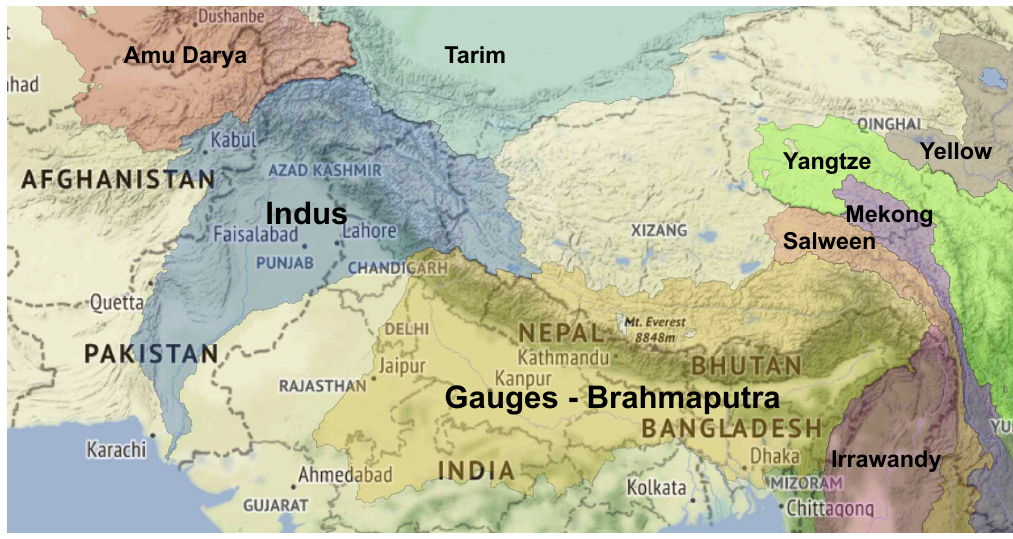
Figure 1. The ten main river basins located in the Hindu-Kush-Karakoram-Himalaya ( HKKH ) region (from west to east): Amu Darya, Indus, Tarim, Ganges, Brahmaputra, Irrawaddy, Salween, Mekong, Yangtze, and Yellow River